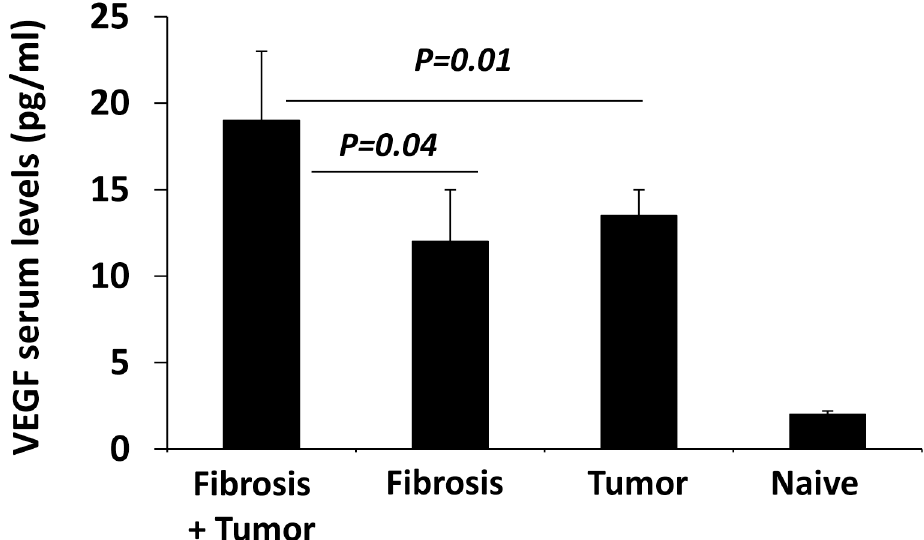
Fig 6. VEGF serum levels. Quantikine Mouse VEGF immunoassay serum levels was significantly increased in the fibrotic group bearing tumor as compared to tumor alone (p = 0.01) or fibrosis alone groups (p = 0.04). No statistical significant differences were found in VEGF serum levels between the fibrotic and non-fibrotic group with tumor induction.